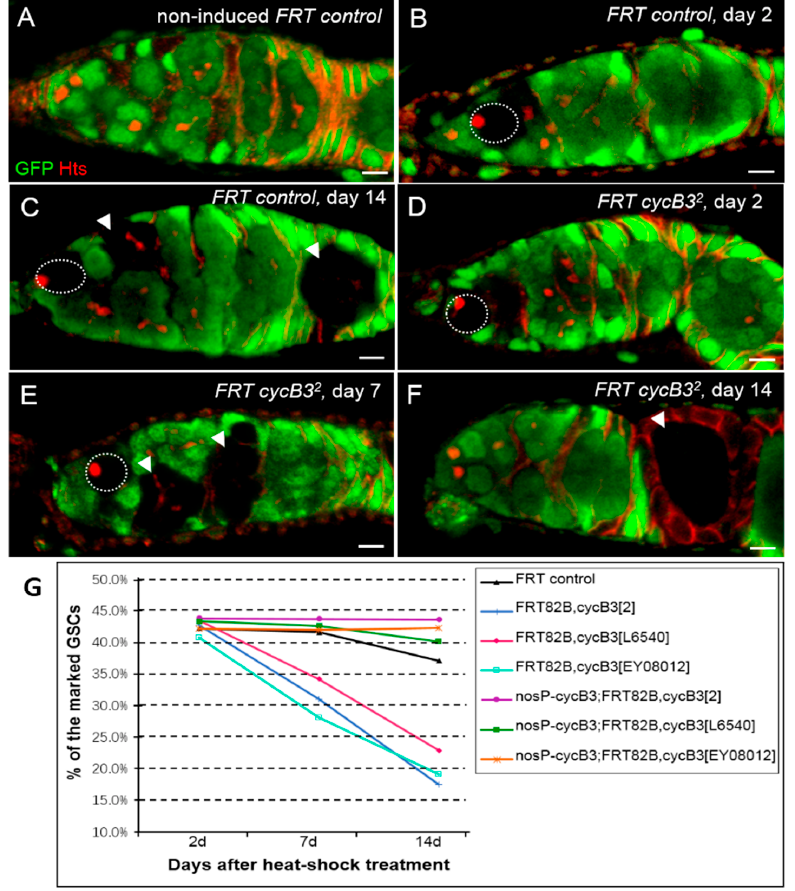
Figure 3. The intrinsic deficiency of cycB3 leads to GSC loss in the Drosophila ovary. ( A – F ) Ovarioles from FRT control ( A – C ) and FRT , cycB3 flies ( D – F ) were collected at different days after heat-shock treatment and stained with anti-GFP (green) and anti-Hts (red) antibodies. GFP-negatively marked GSC clones (indicated by dashed circles) and cyst clones (noted by arrowheads); ( G ) Percentages of negatively GFP-marked GSC clones in FRT control and cycB3 mutant alleles, at days 2, 7 and 14. Compared with marked GSCs (GFP-) in FRT control, the percentages of marked cycB3 mutant GSCs (GFP-) decreased dramatically. Scale bars: 5 μ m.